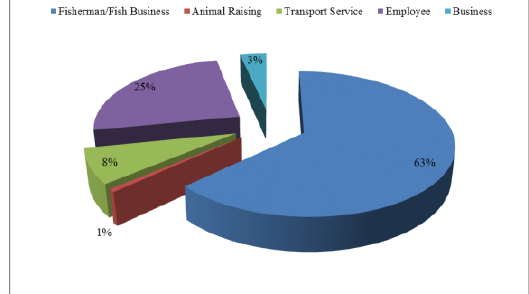
Figure 9. The percentage of the primary sources of income in the three